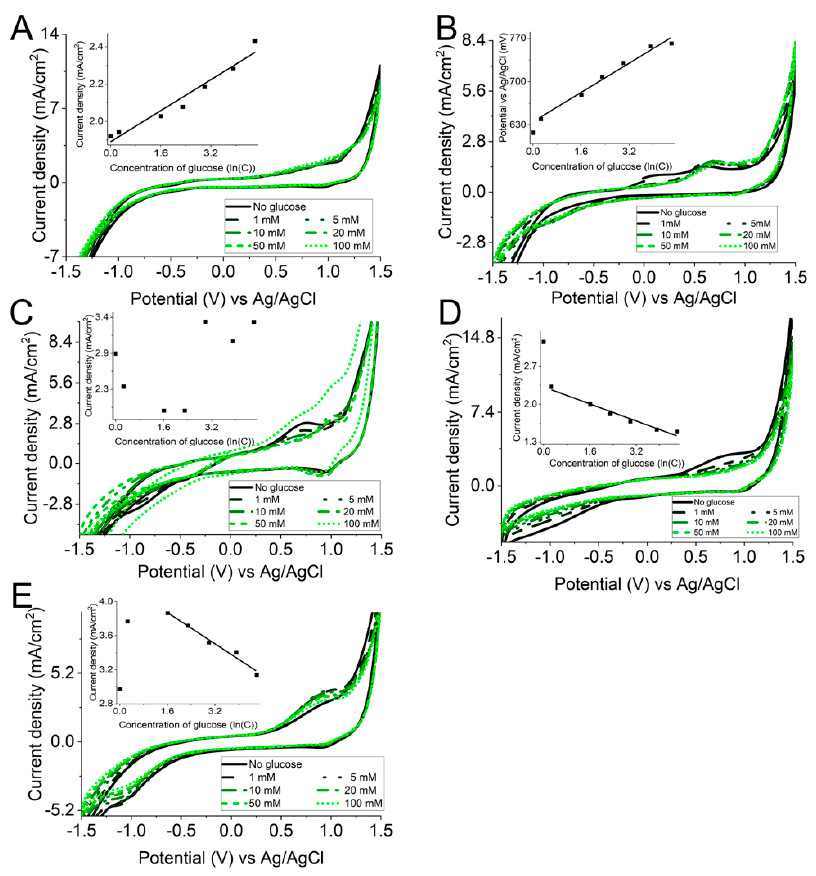
Figure 4. Cyclic voltammograms when the working electrode is ( A ) control of the study; ( B ) EBFC CC ; ( C ) EBFC CA ; ( D ) EBFC ChV ; and ( E ) EBFC Hep .